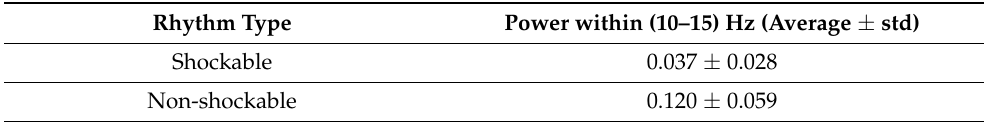
Figure 6. Box plots for comparing spectral power in the frequency band (10–15) Hz for shockable and non-shockable samples for the validation set. Table 3. Estimated power (watt/Hz) in the validation samples for frequencies within (10–15)